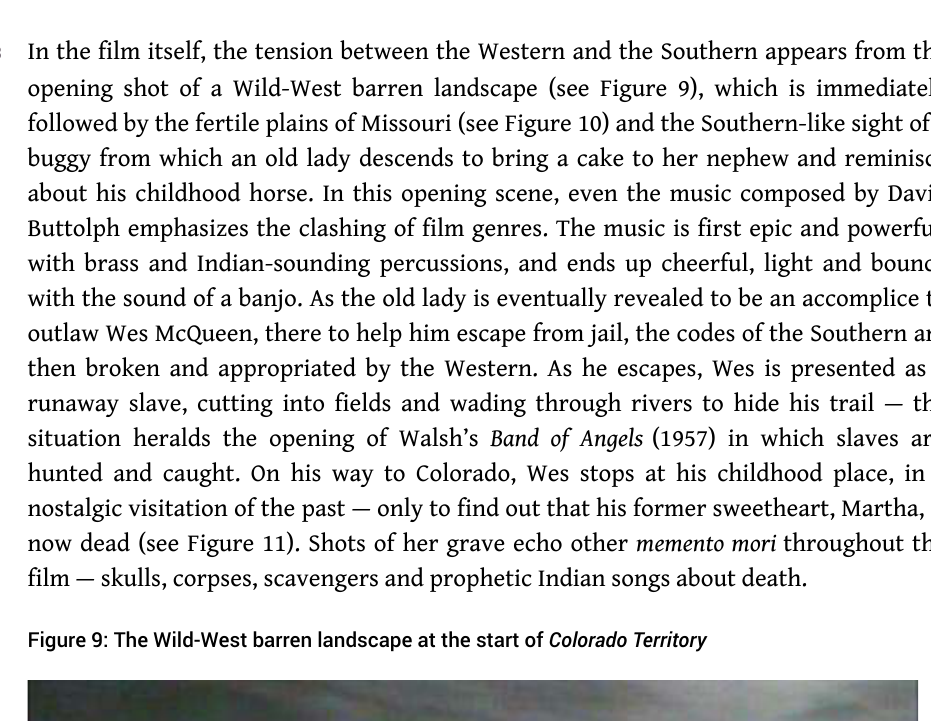
Raoul Walsh, between the Western and the Southern: Pursued (1947), Silver